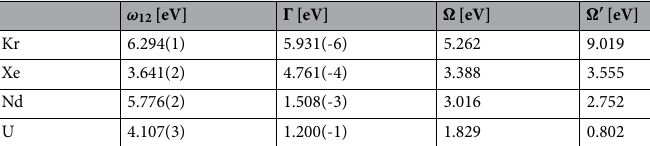
10 14 W/cm 2 . x ( y ) stands for x =